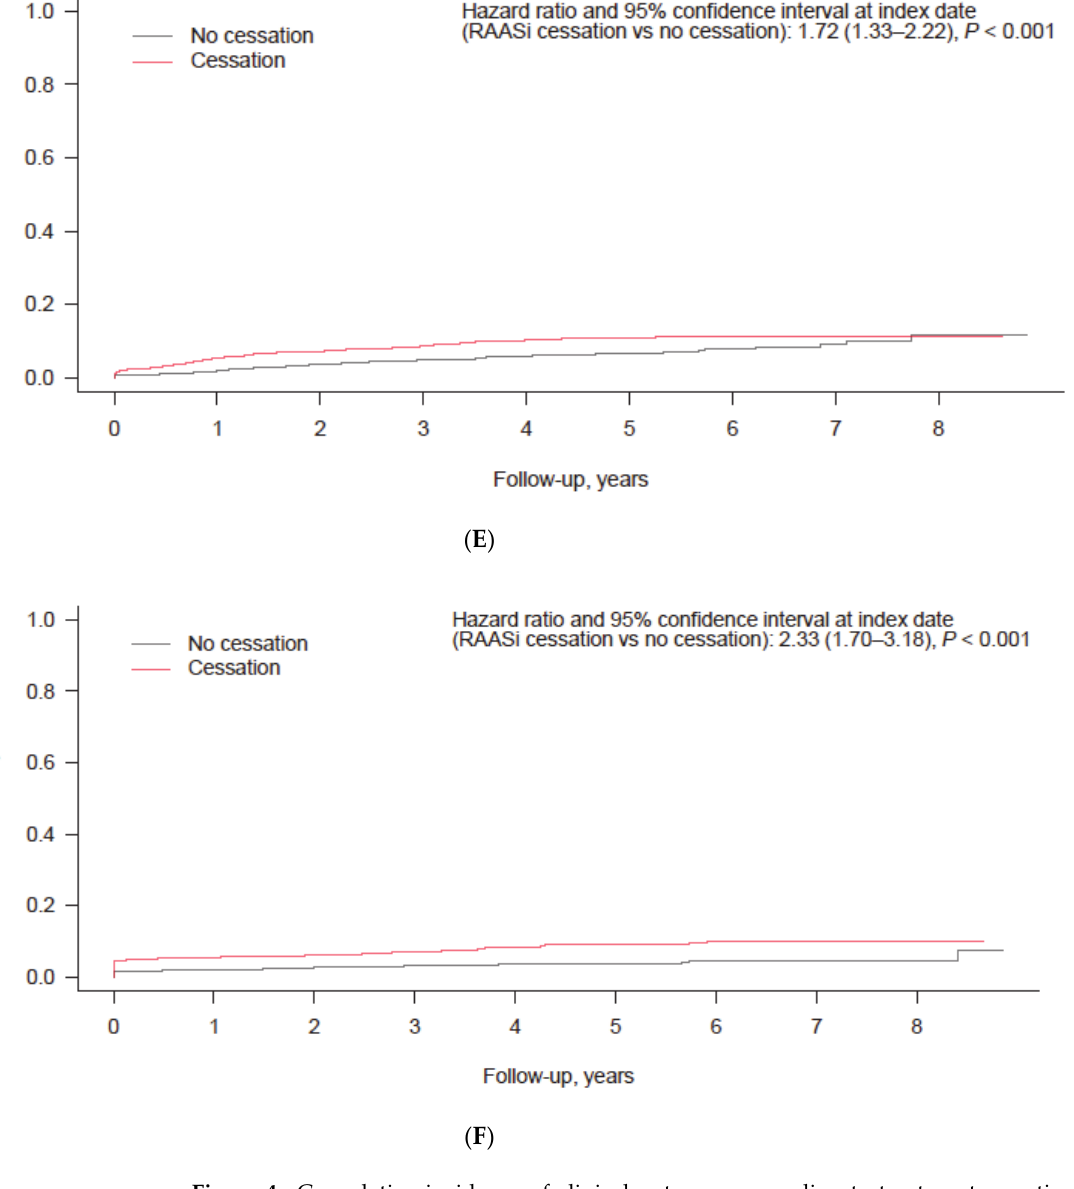
Figure 4. Cumulative incidence of clinical outcomes according to treatment cessation and non- cessation in propensity score-matched patients receiving any RAASi therapy (cumulative incidence function analysis). ( A ) In-hospital death; ( B ) emergency room visits; ( C ) hospitalization; ( D ) hospitalization due to heart failure; ( E ) renal replacement therapy; ( F ) hospitalization for MI, arrhythmia, or cardiac arrest. Abbreviations: MI, myocardial infarction; RAASi, renin–angiotensin–aldosterone system inhibitor.